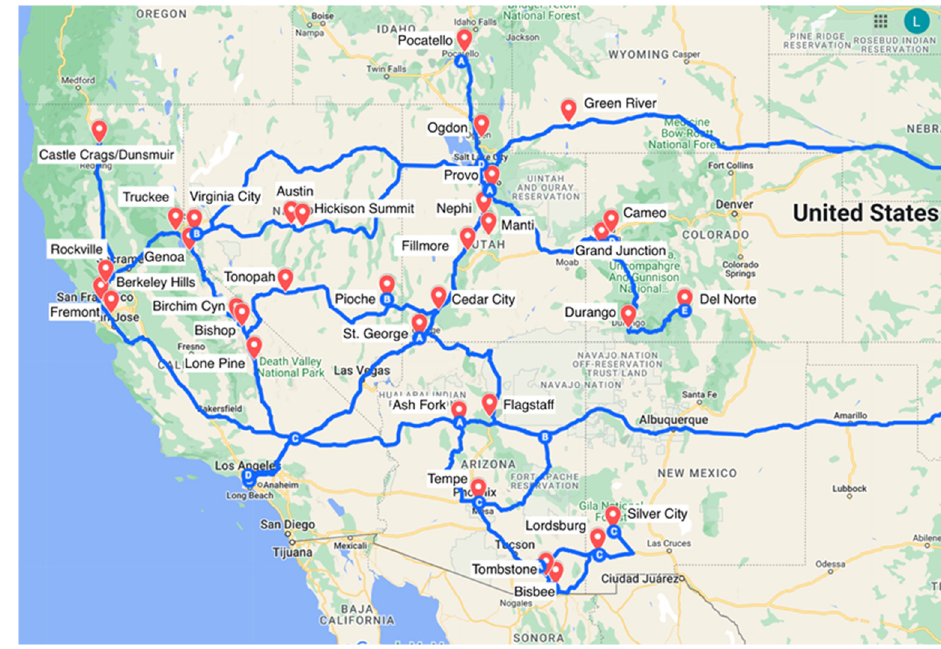
Figure 5. Routes of travel associated with Western Message Petroglyph sites.